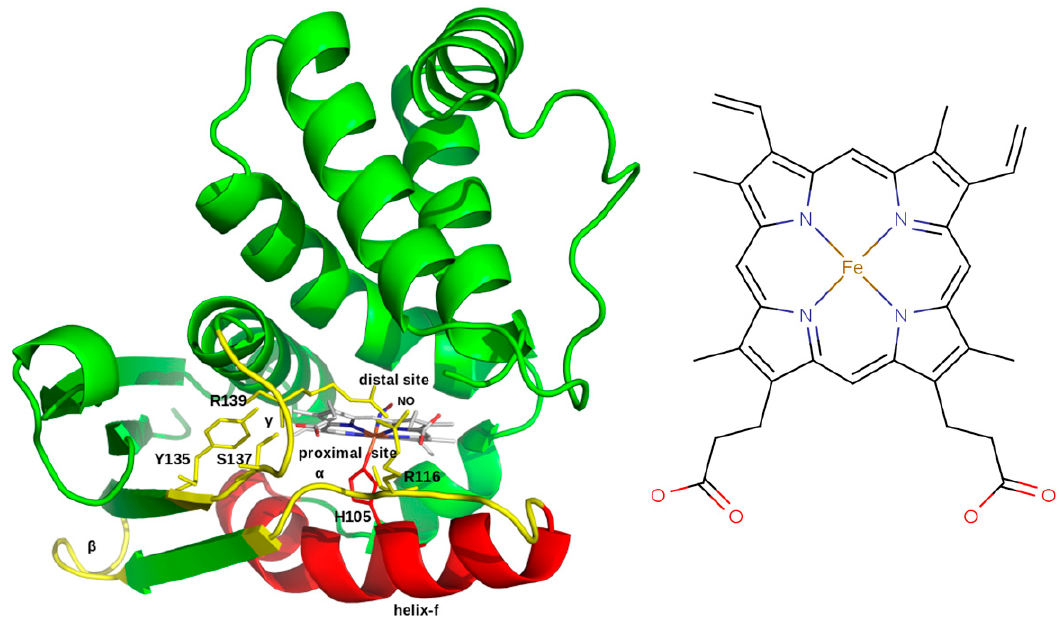
Figure 1. Predicted model of the 6c coordination state of the Human HNOX domain where the binding pocket heme is ligated to NO (6c NO-HNOX). The Y135-S137-R139 (Y-S-R) motif that bears strong interactions with the heme propionic moiety is also labeled (yellow). Functionally critical regions are also labeled as helix-f (red), loop α , β , and γ (yellow). A simple chemical scheme of heme is shown in the right panel. A detailed scheme of the heme interactions for each system are shown in Figure 7.